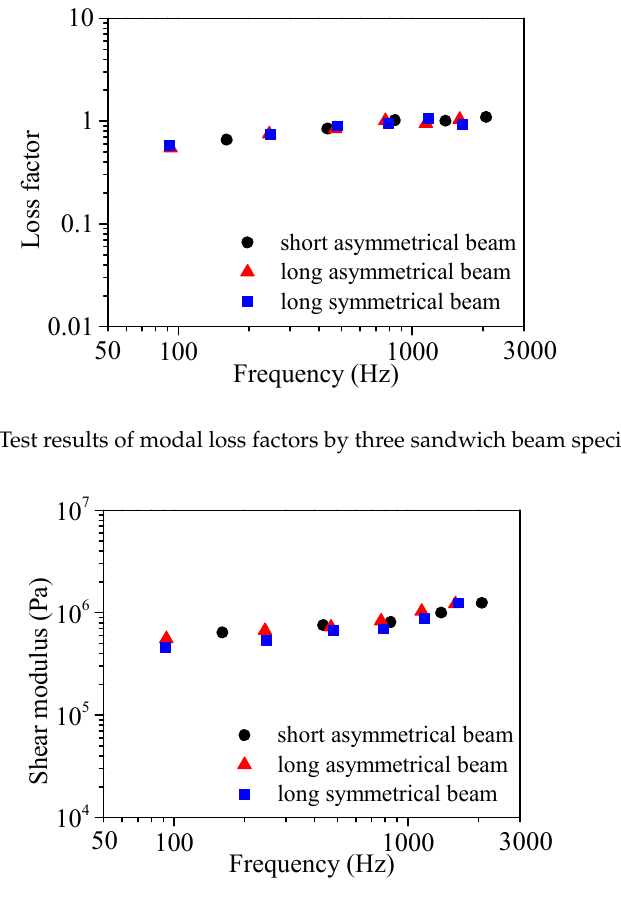
Figure 12. Test results of modal shear moduli by three sandwich beam specimens.